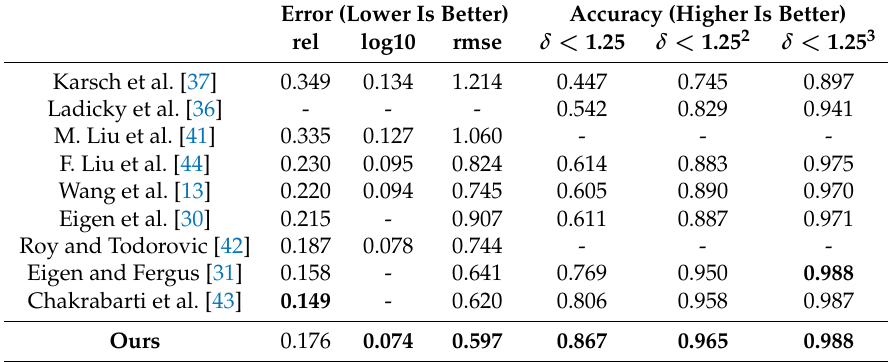
Table 1. This table shows the comparison of our method with the several state-of-the-art baselines. The values are adopted from their respective papers. The bold fonts represent the best performing result. The dashes are missing values on the particular evaluation metric not reported by the authors in their paper. Error (Lower Is